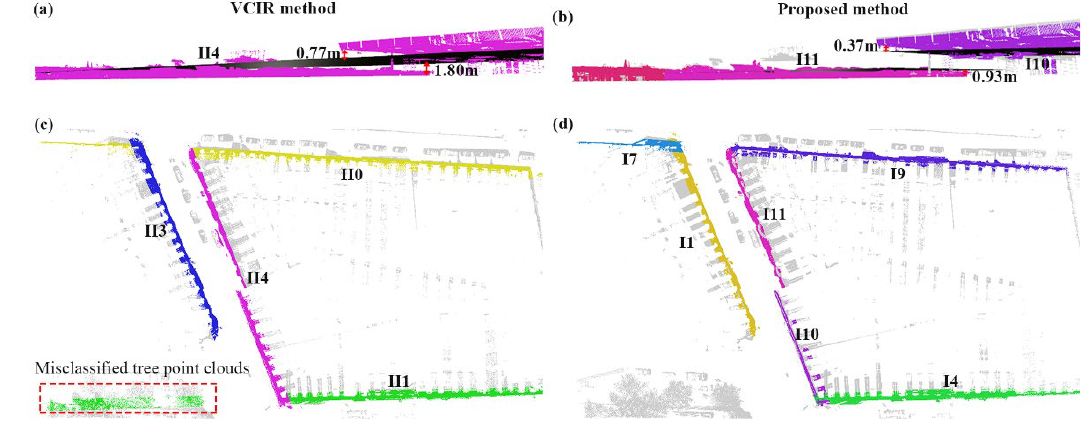
Figure 18. Details of planes extracted by the VCIR method ( a , c ) and the details of facades extracted by the proposed method ( b , d ): ( a , b ) the details of plane II4 extracted by the VCIR method corresponding to the facades I10 and I11 extracted by the proposed method; and ( c , d ) the details of plane II1 extracted by the VCIR method corresponding to the facade I4 extracted by the proposed method.